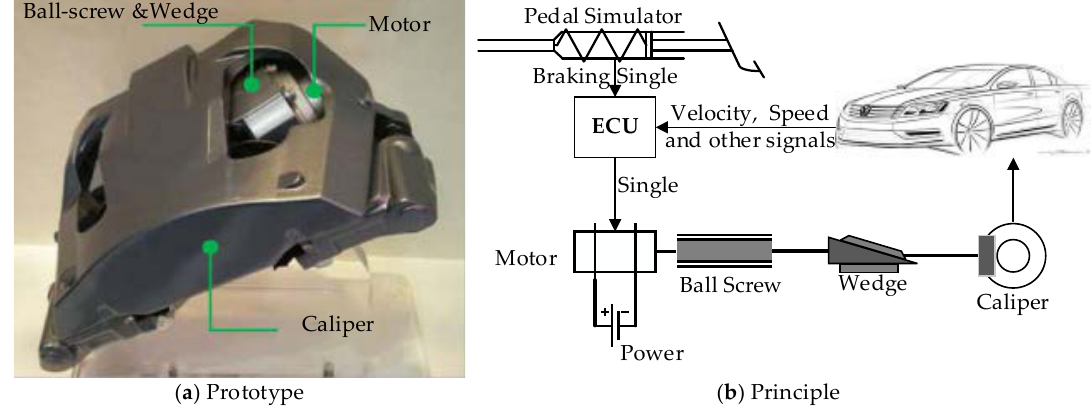
Figure 5. Electronic-wedge brake.